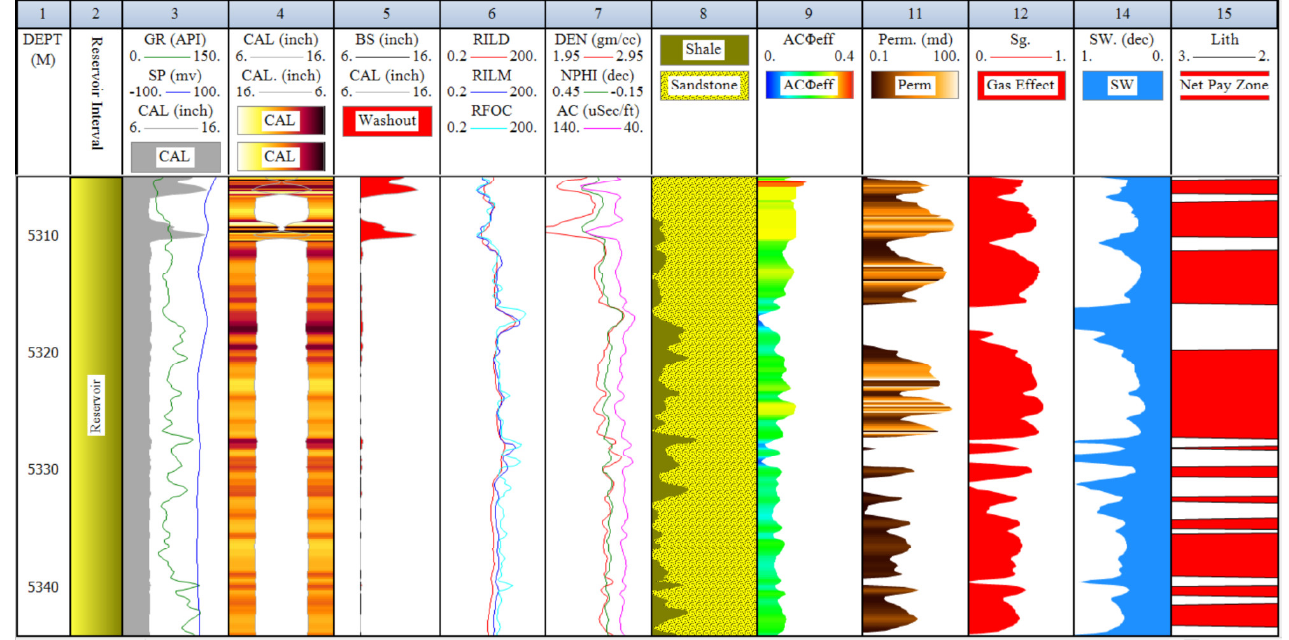
Figure 3. The conventional log overview and litho saturation cross plot of YK16 in the Yakela gas condensate field indicates that the current research Formation (zones) reveals a significant number of sub-reservoir gas zones, where the average water saturation value is 36 percent.